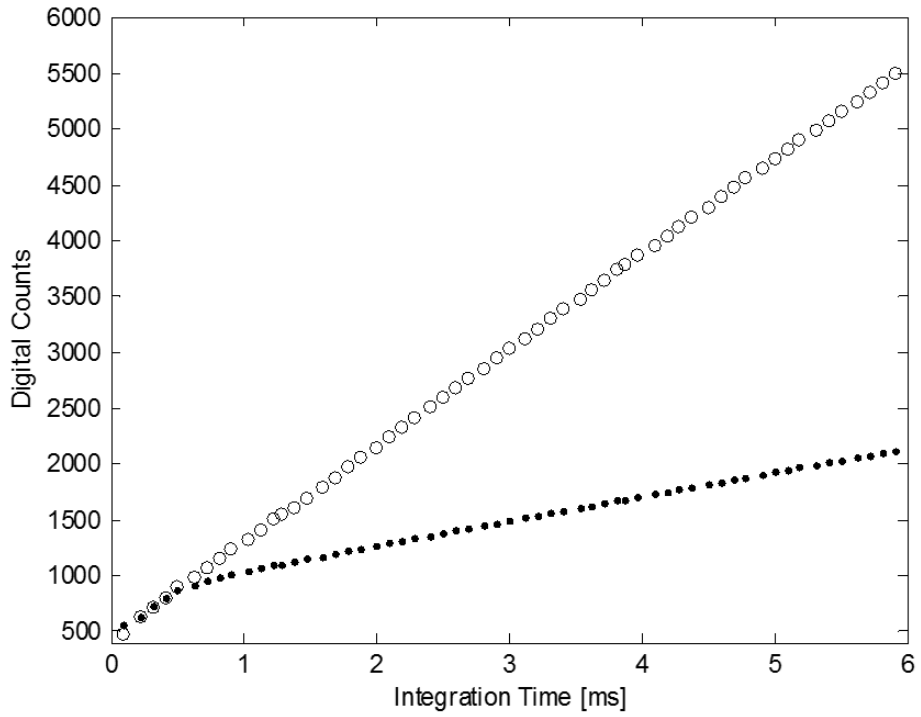
Figure 4. Example of applying the linearization algorithm to integration time sweep data for one detector. The original raw digital counts are shown as black dots, while the associated linearized counts are shown as open circles. The linearization algorithm transforms the detector gains into the gain of the lower response